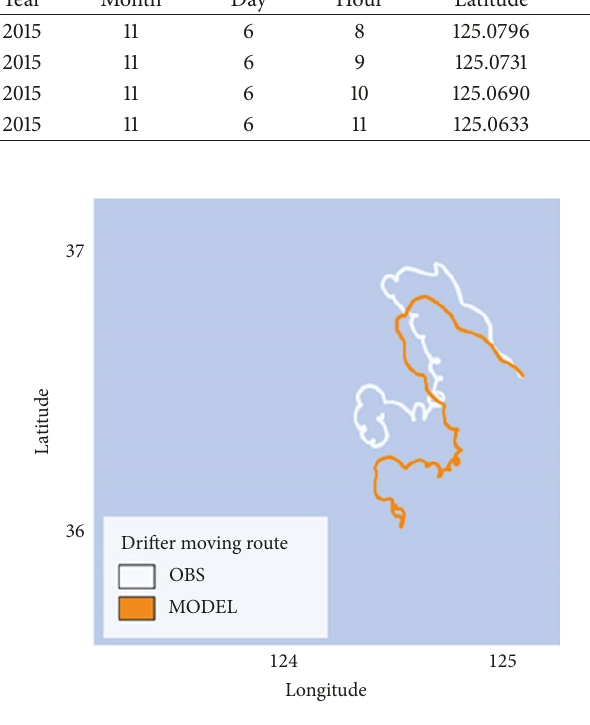
Figure 3: Observed trajectory of drifter (OBS) and predicted one of MOHID model to be compared with our predicted models (Case 1